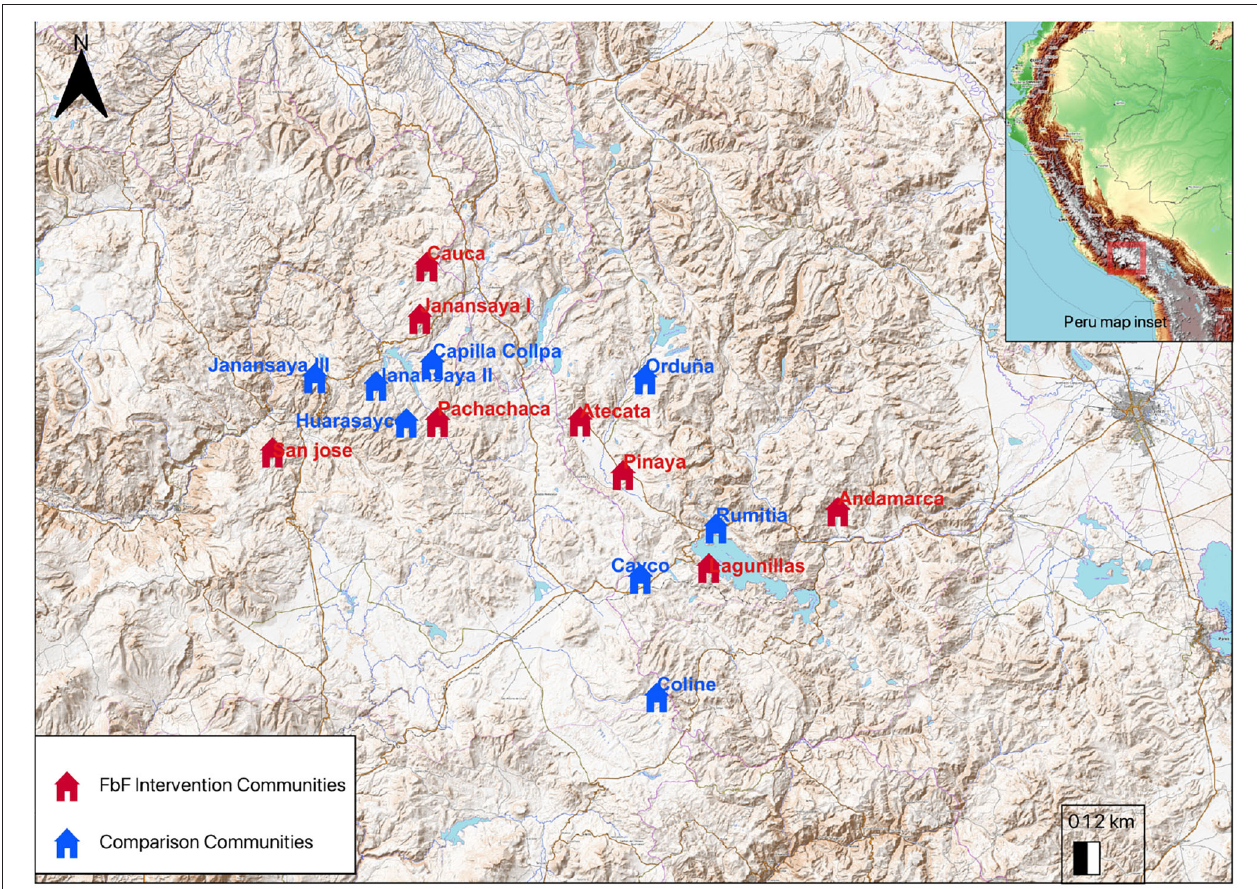
FIGURE 3 | Location of intervention and comparison communities in the districts of Arequipa (Caylloma) and Puno (Santa Lucia).